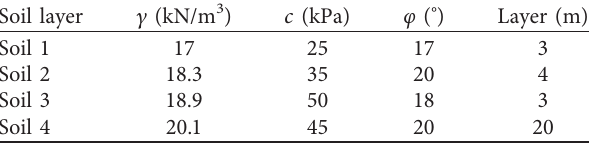
Table 1: Soil basic physical property index.